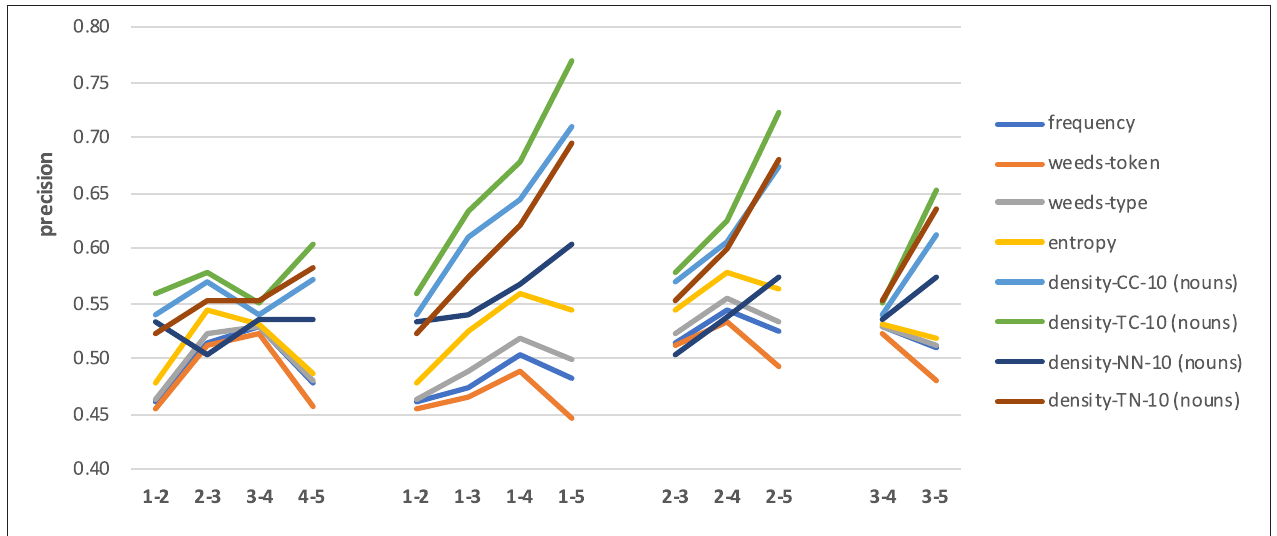
FIGURE 9 | Results across combinations of concreteness ranges for nouns.